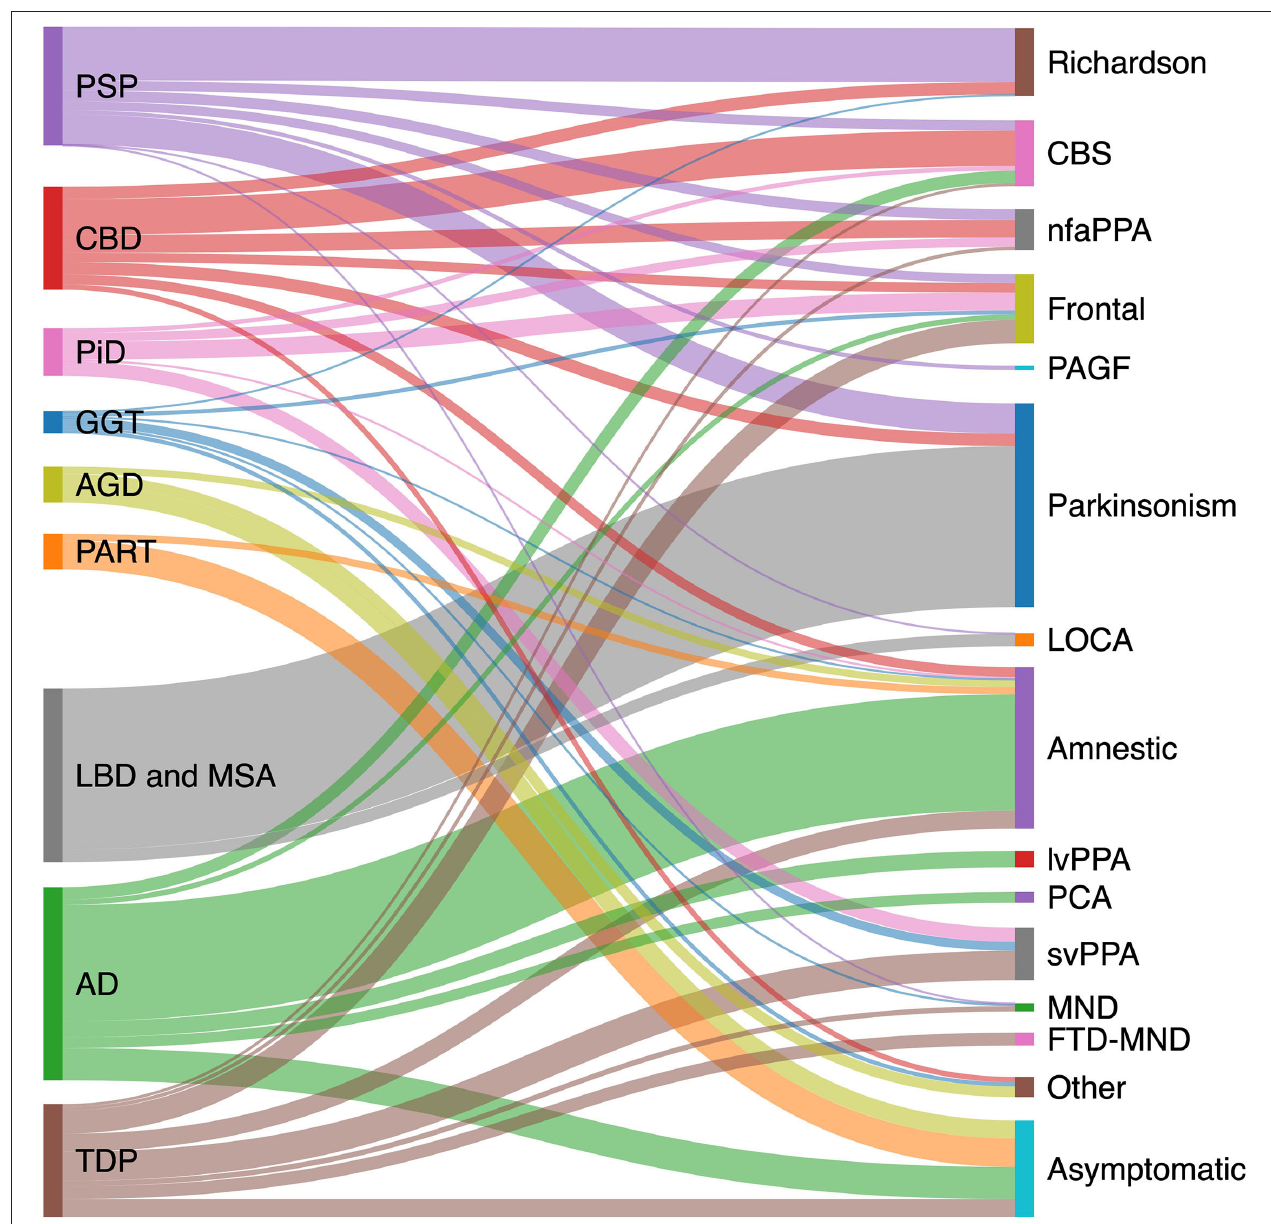
FIGURE 1 | Clinicopathological correlation in tauopathies spectrum. Pathologic diagnoses are shown on the left and clinical syndromes on the right. Degree to which various pathologies contribute to a specific clinical phenotype is estimated based on available pathology-confirmed studies, including: PSP (20–23); CBD (23–27); AD (28–31); PiD (32); LBD (33); GGT (34); TDP (35–37); AGD (38); and PART (15, 39, 40). AD, Alzheimer’s disease; AGD, argyrophilic grain disease; CBD, corticobasal degeneration; CBS corticobasal syndrome; FTD-MND, frontotemporal dementia-motor neuron disease; GGT, globular glial tauopathy; LBD, Lewy body disease; LOCA, late onset cerebellar ataxia; lvPPA logopenic variant primary progressive aphasia; MND, motor neuron disease; nfaPPA, non-fluent agrammatic primary progressive aphasia; PAGF, progressive akinesia and gait freezing; PART, primary age-related tauopathy; PCA, posterior cortical atrophy; PiD, Pick’s disease; PSP, progressive supranuclear palsy; svPPA, semantic variant primary progressive aphasia; TDP, transactive response DNA binding protein 43 kDa pathology.